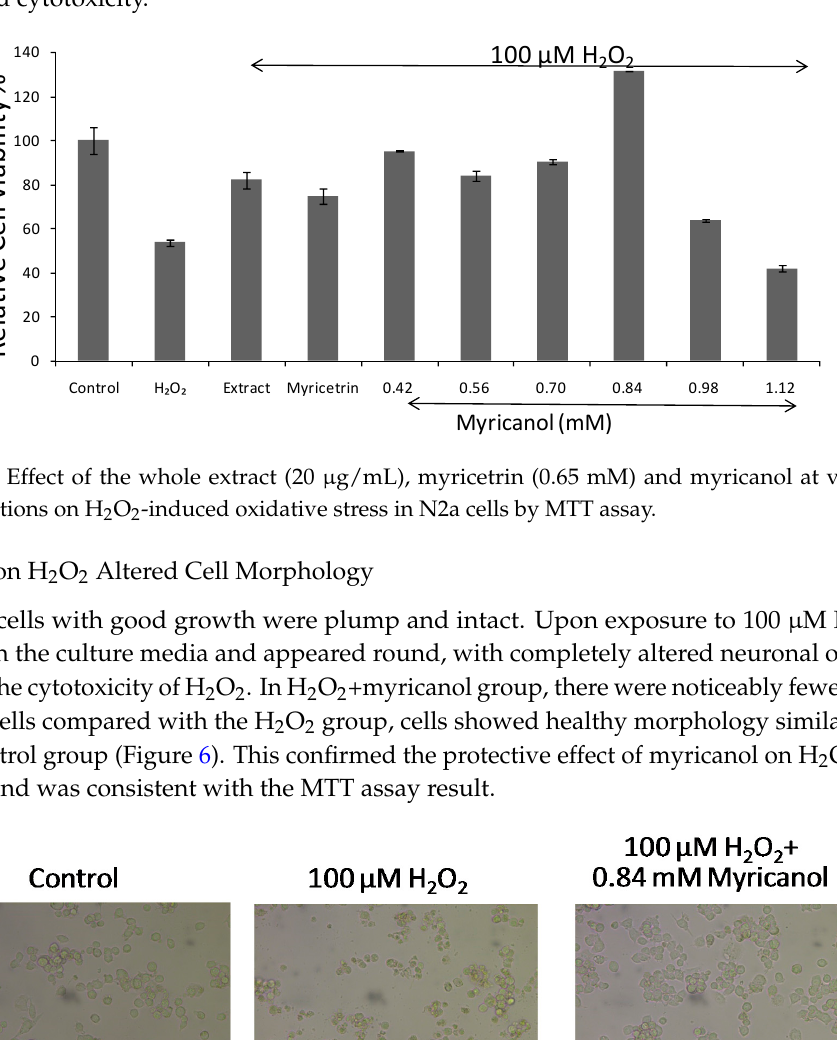
Figure 6. Effect of myricanol on H 2 O 2 -induced cell morphological changes.